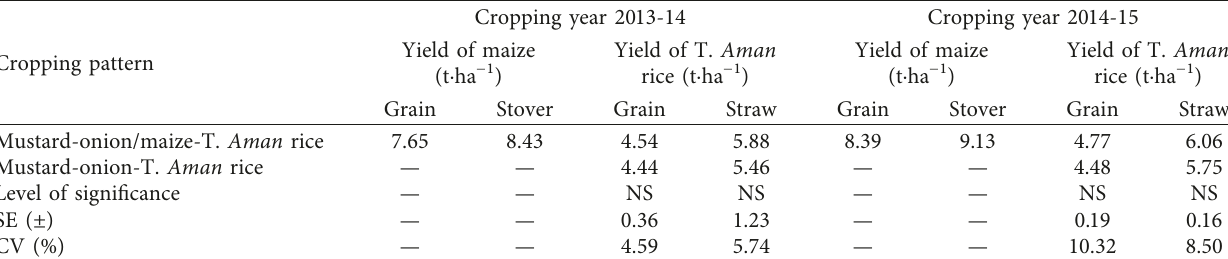
Table 3: Productivity of component crops (maize and T. Aman rice) in different cropping patterns. Cropping pattern